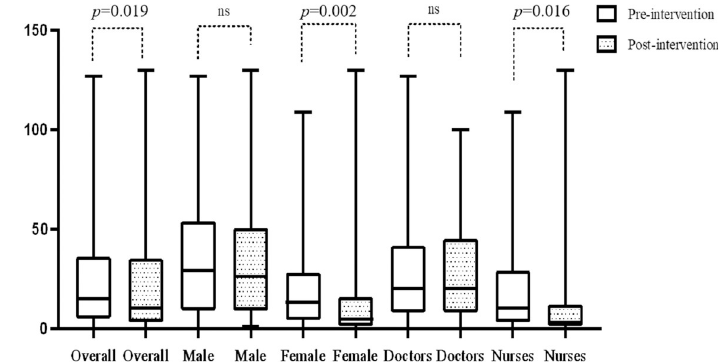
Fig 2. Changes in colony forming units of bacteria isolated from stethoscopes during pre- and post-intervention period. CFUs, colony forming units; ns, non-specific.